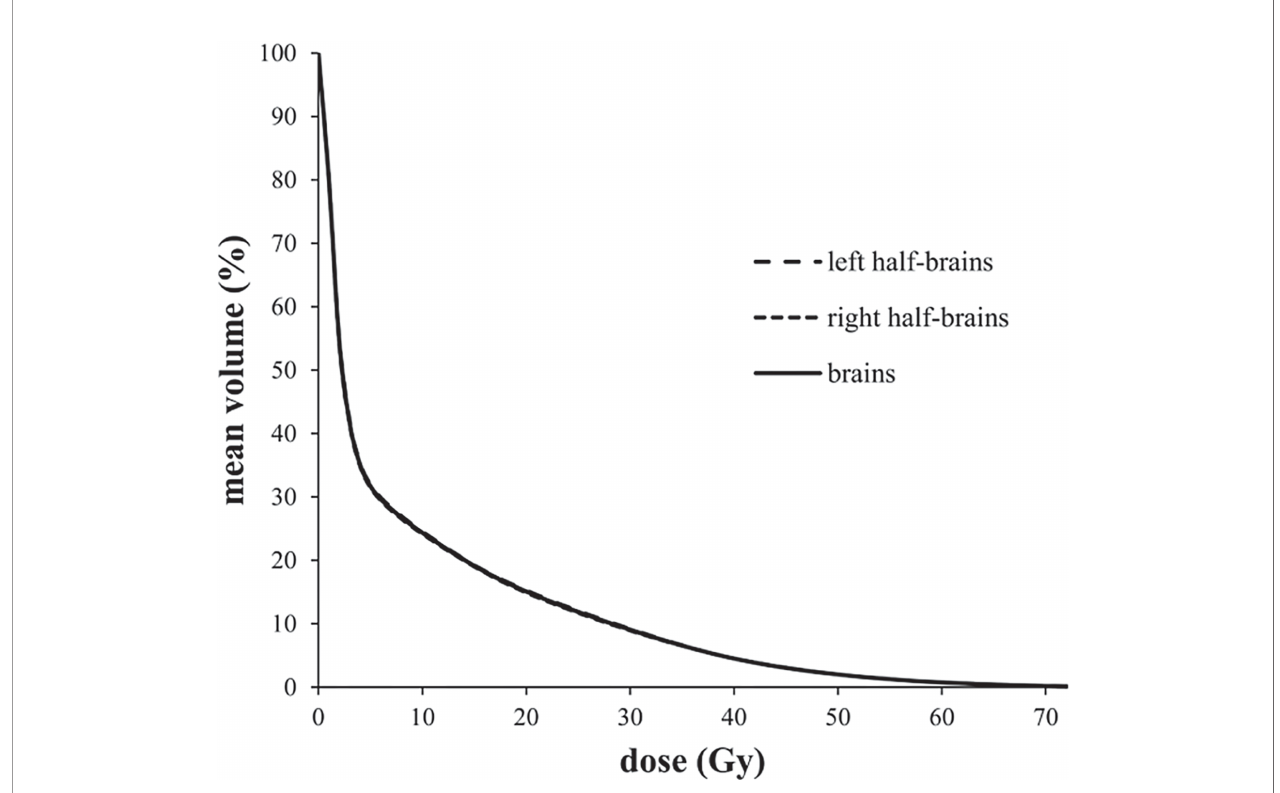
FIGURE 1 | Average-DVH curves of left half-brains, right-half-brains and